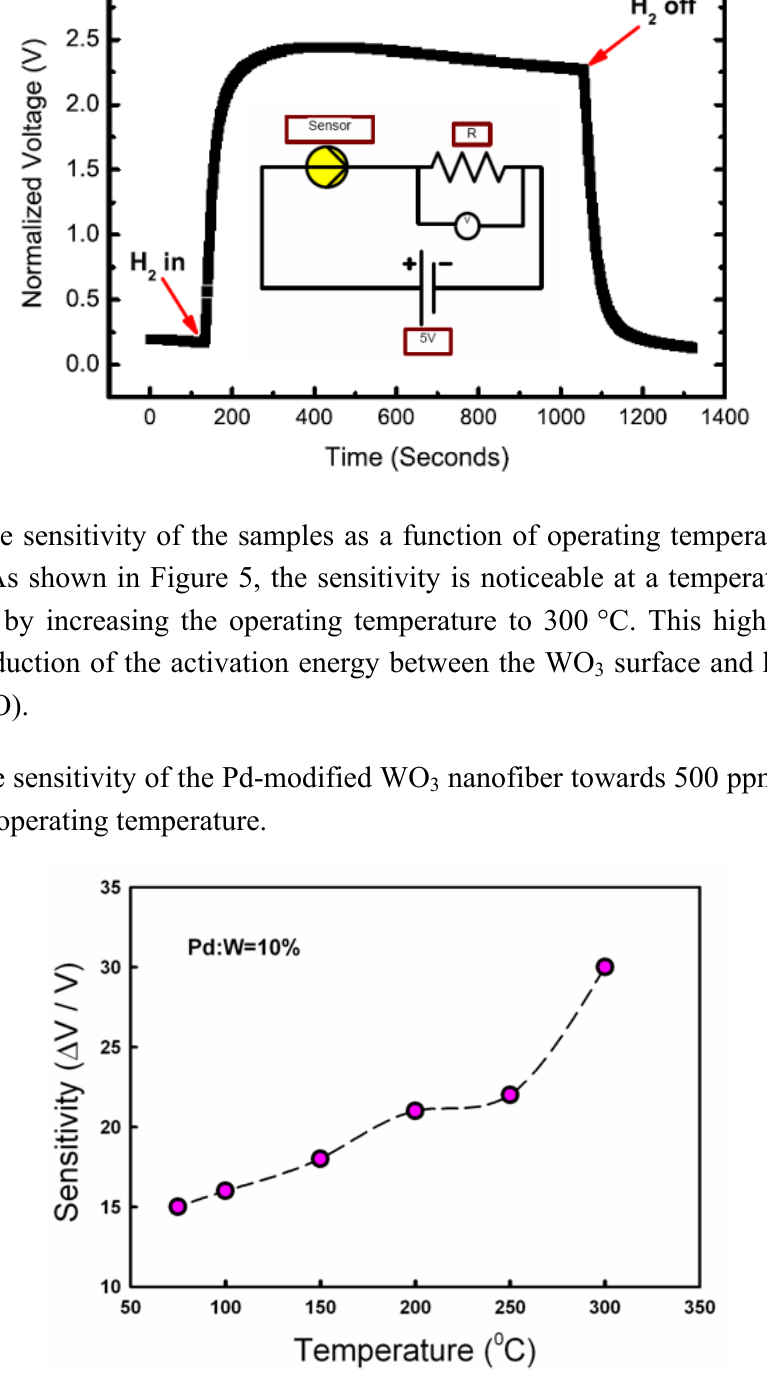
Figure 4. Normalized voltage variation across the series resistor as output signal